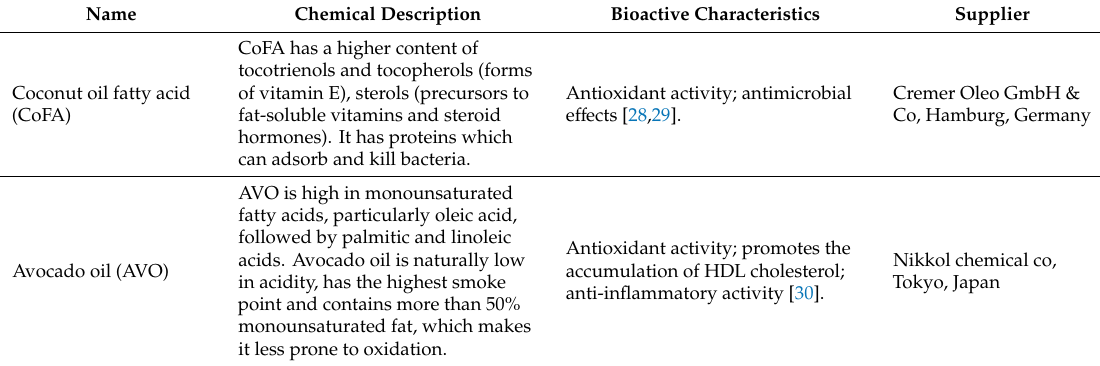
Table 1. The major chemical compositions and therapeutic benefits of bioactive excipients used in current studies, along with their suppliers’